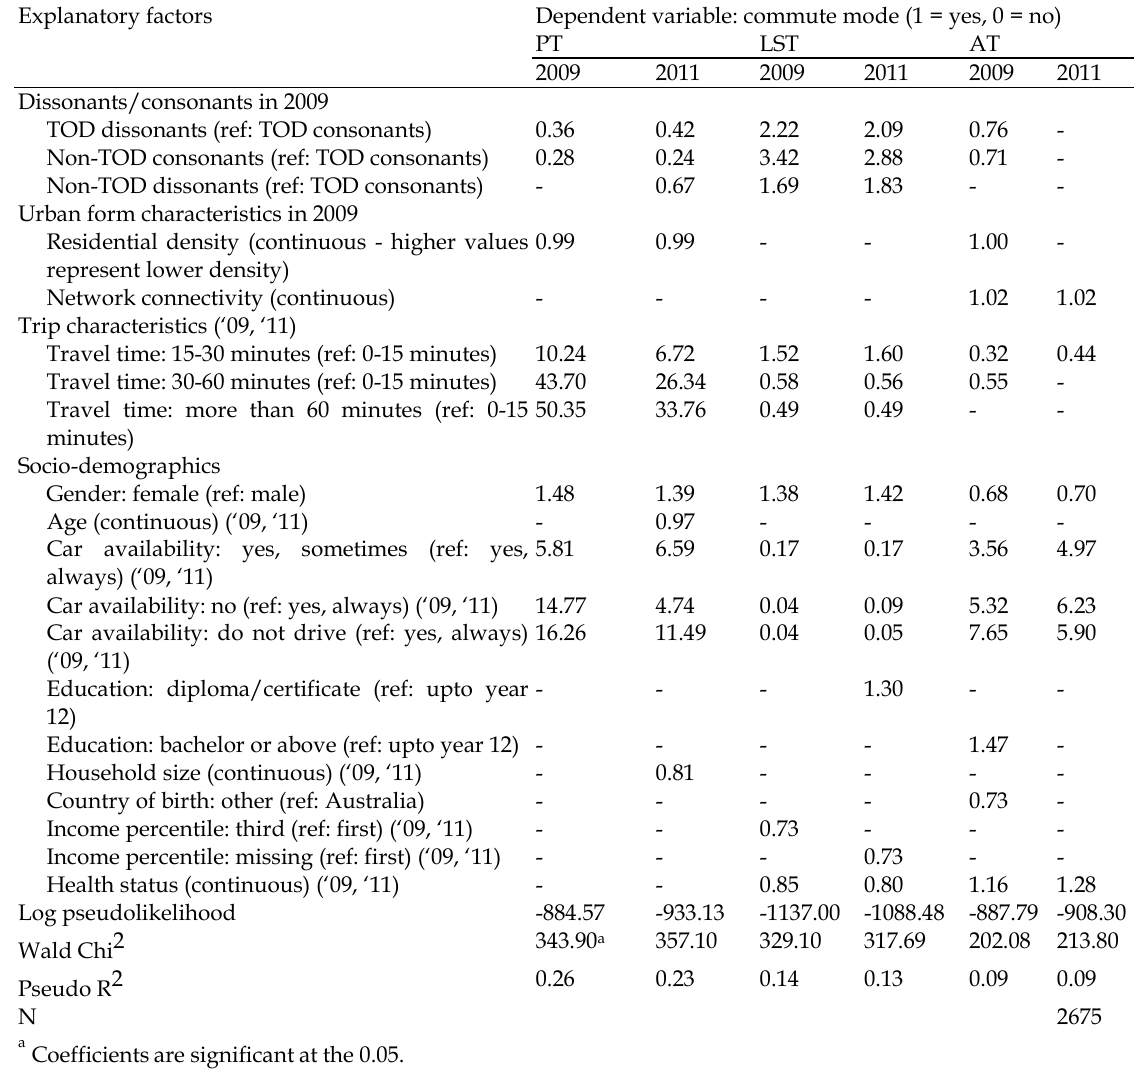
Table 4. Binary logistic regression analysis results showing the ORs associated with mode choice behaviour in 2009 and 2011 (Std. Err. adjusted for 200 clusters in CCDs) Explanatory